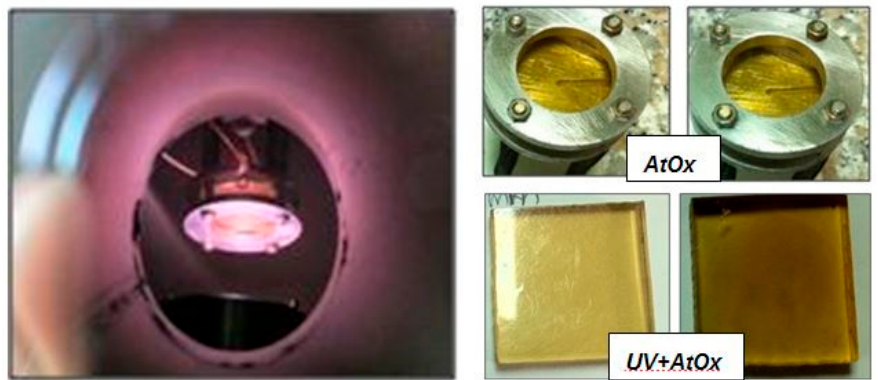
Figure 6. UV/AtOx aging characterization: chamber inside during the test, and Radel R samples before and after exposure, for both AtOx alone and UV+AtOx irradiation.